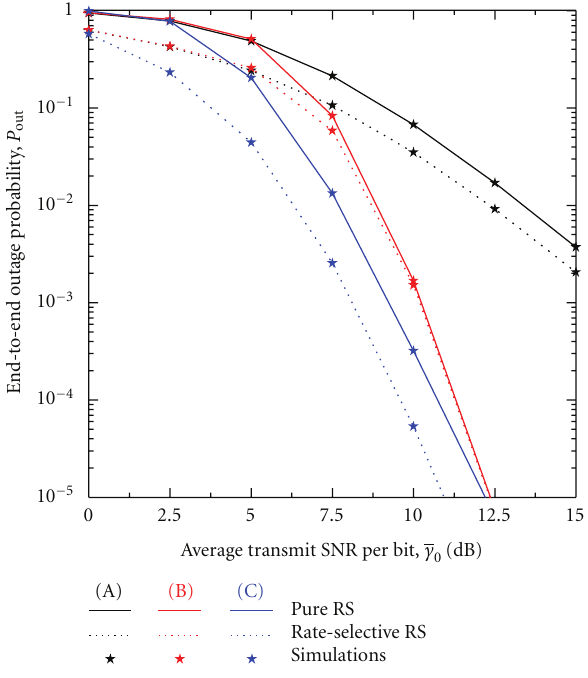
Figure 5: End-to-end OP, P out , of RS versus the average transmit , for L = 2 relay nodes over INID Nakagami- m SNR per bit, γ 0 fading channels: (A) m 0 = m 1 = m 2 = 1 and δ = 0 . 3, (B) m 0 = 1, m 1 = m 2 = 6, and δ = 0 . 3, and (C) m 0 = m 1 = m 2 = 3 and δ =